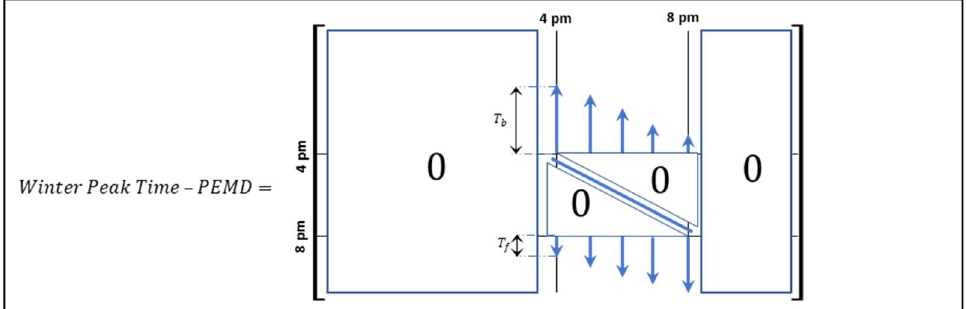
Figure 16. Winter peak time—PEMD under the proposed DR policy.